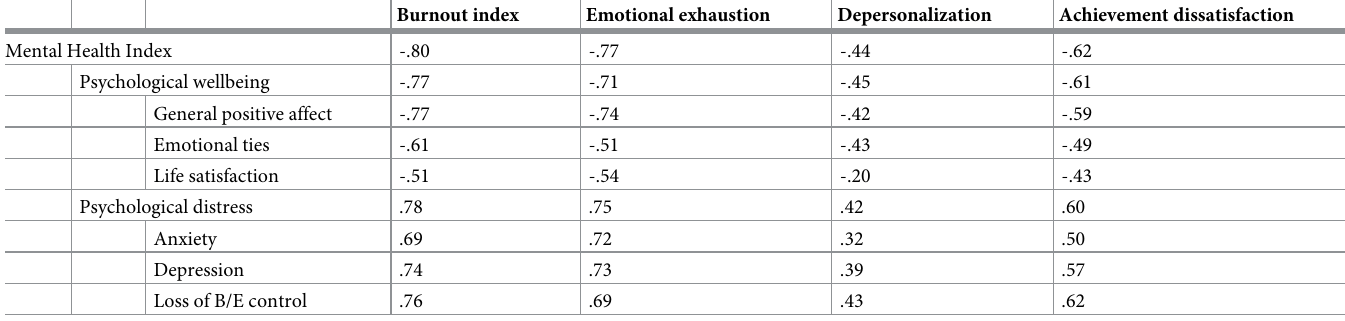
Table 2. Correlations between mental health indicators and burnout